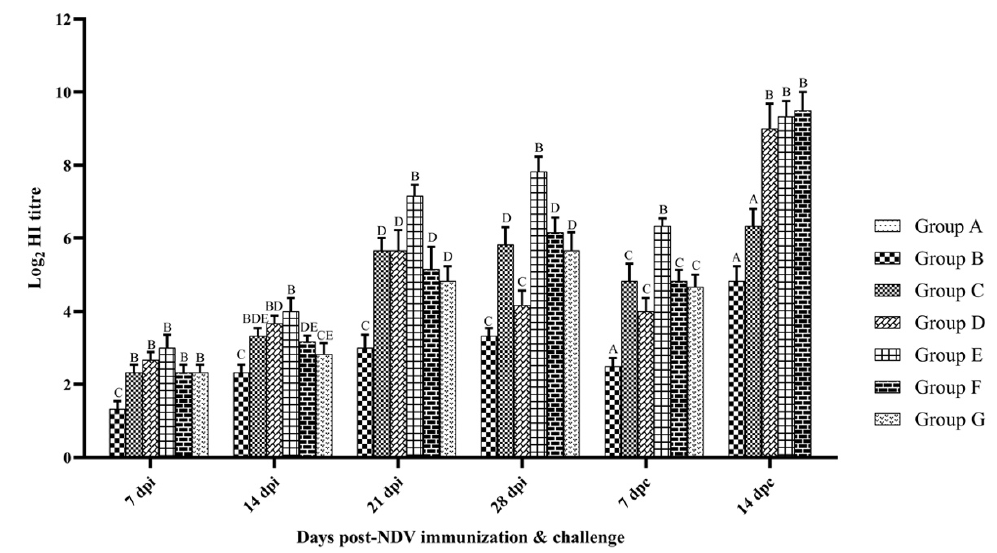
Figure 1. Hemagglutination inhibition antibody titers in SPF chicken following immunization and challenge. Treatment effect was analyzed at each time point by two-way ANOVA with Tukey’s test as post hoc test. The probability of an alpha error was set at 0.05. Different superscripts above bars (mean ± SE) indicate significant difference between groups ( p < 0.05). dpi: days post-NDV immunization; dpc: days post-challenge. Group A: Control; group B: Commercial NDV vaccine; group C: inactivated NDV vaccine; group D: inactivated NDV vaccine with LPS; group E: inactivated NDV vaccine with R-848; group F: inactivated NDV vaccine with LPS (25 µ g) + R-848 (25 µ g) and group G: inactivated NDV vaccine with LPS (50 µ g) + R-848 (50 µ